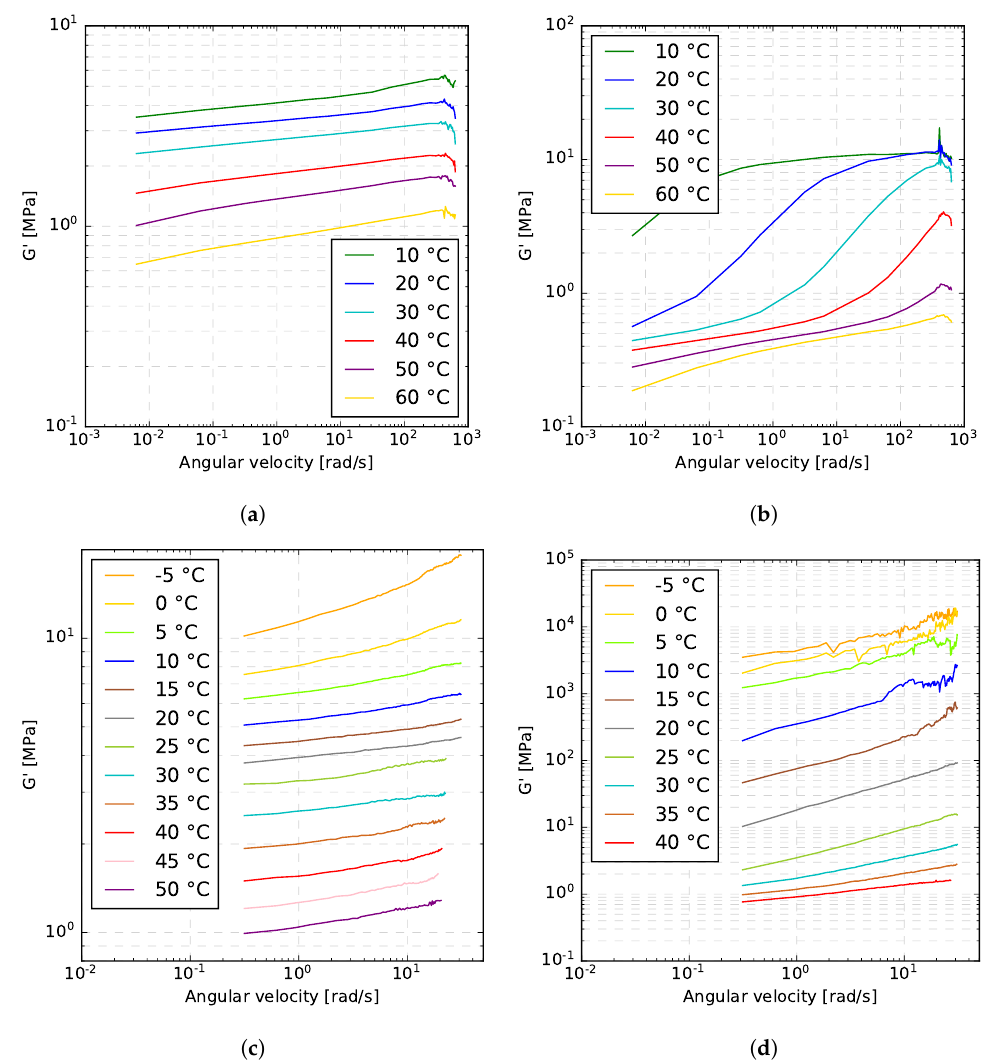
Figure 12. Storage modulus–frequency relations for a selected EVA ( a , c ) and PVB ( b , d ) specimen: ( a , b ) dynamic torsion test, ( c , d ) single-lap shear test.